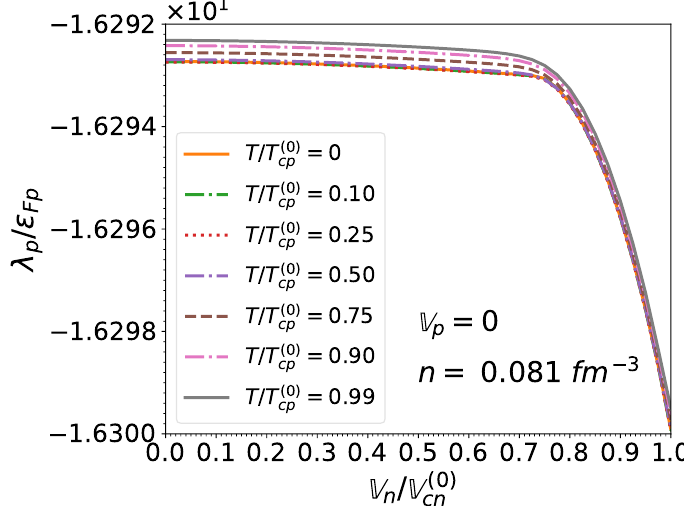
Figure 18. Upper panel: neutron chemical potential λ n normalized to the associated Fermi energy ε Fn as a function of the normalized neutron effective superfluid velocity V n / V ( 0 ) temperature T / T cn for npe µ matter in beta-equilibrium at the crust-core interface and for Lower panel: same for the proton chemical potential λ p .